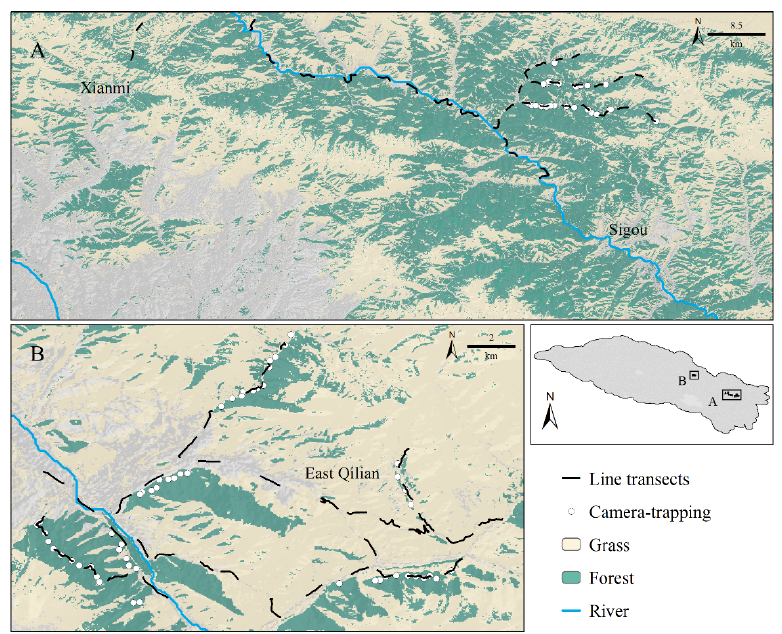
Figure A2. Location of line transects and camera-trapping in the Qilian Mountains. Field study was mainly carried out at Xianmi, Sigou (A) and East Qilian (B).